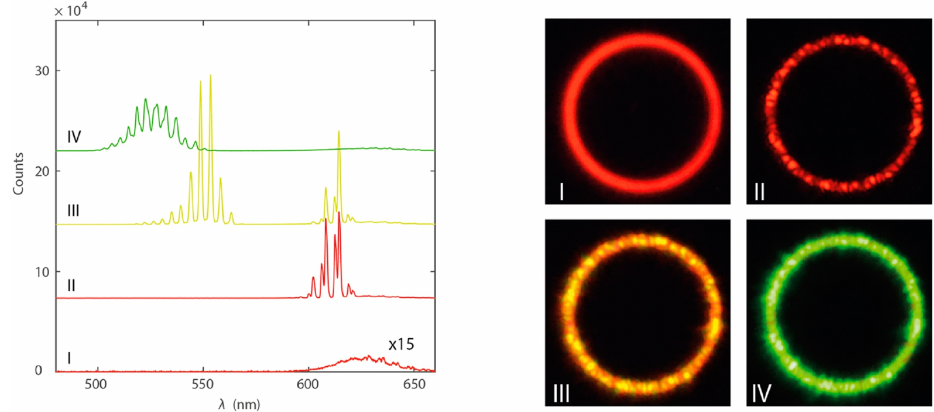
Figure 8. ( left ) Emission spectra of the microring lasers as a function of the excitation density, evidencing the emission color variation. ( right ) True-color photographs of a 4 µ m radius QD ring laser excited in the power regimes, I–IV. Adapted from [73]. American Chemical Society,